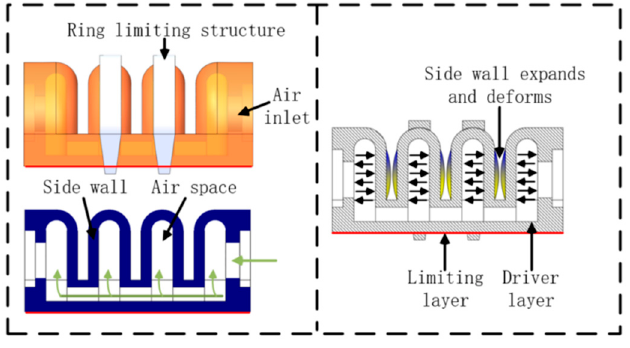
Figure 2. Schematic diagram of the drive structure.